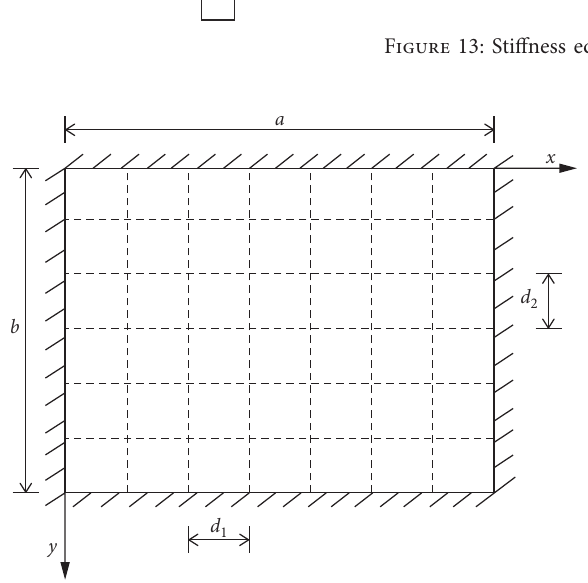
Figure 14: Floor with four built-in